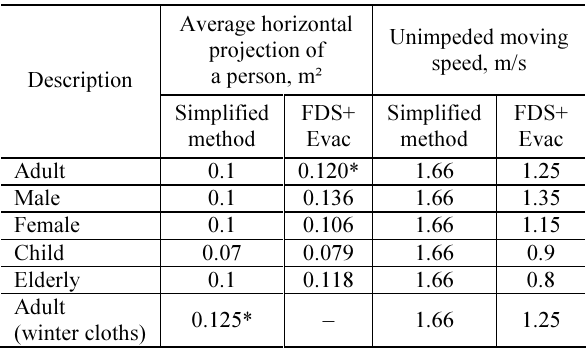
Table 2. The summary of a human average horizontal projec- tion and unimpeded moving speed used in simplified and FDS+Evac methods